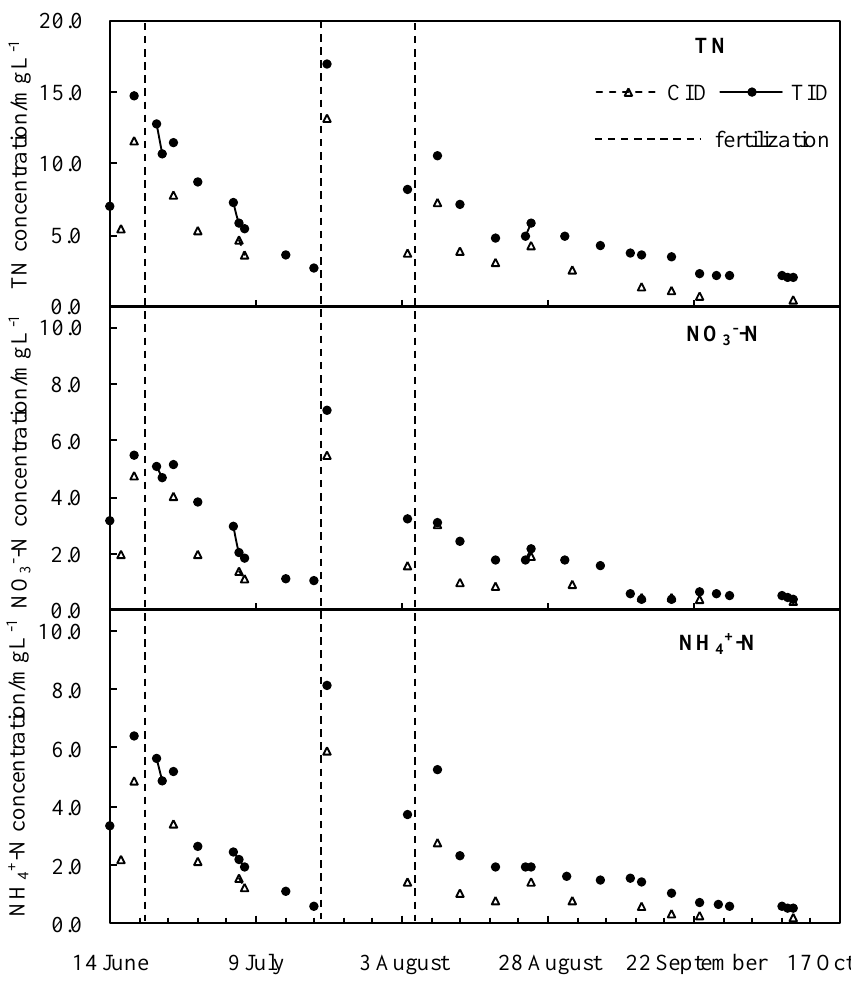
Figure 6. Nutrient concentration of drainage water sampled at the outlets of the CID and TID modes.